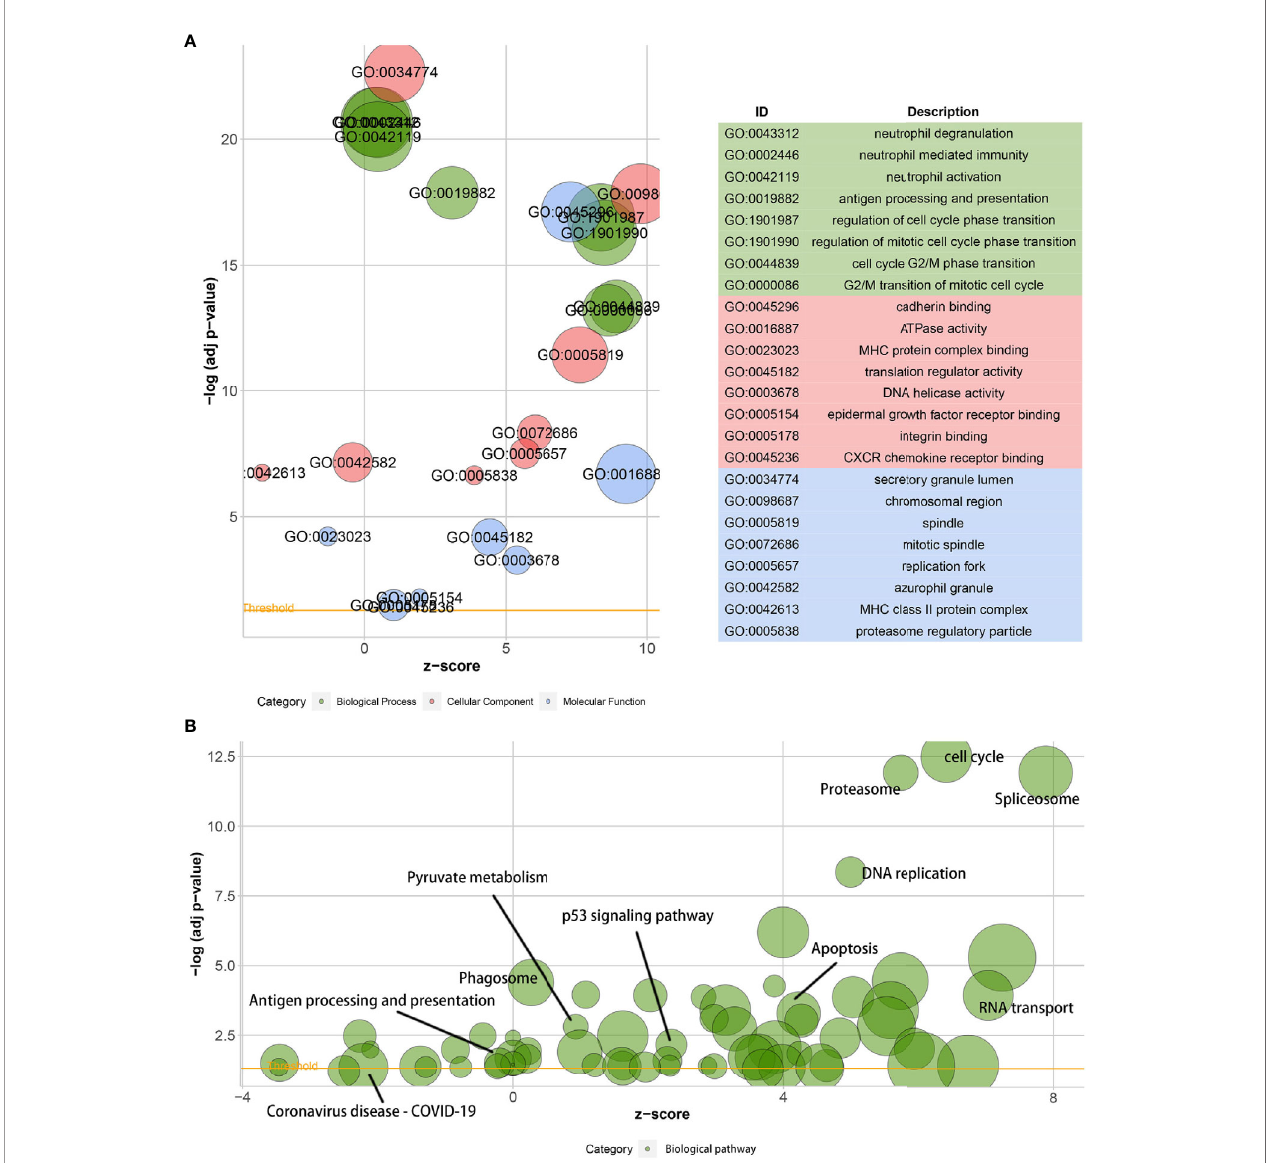
FIGURE 6 | Gene ontology (GO) and the Kyoto encyclopedia of genes and genomes (KEGG) enrichment analyses. Bubble charts of the GO function analysis (A) and the KEGG pathway analysis (B) of DEGs among samples, which are divided into high and low KIF11 expression subgroups relative to the median KIF11 expression levels. The higher the z-score, the higher the expression of enriched